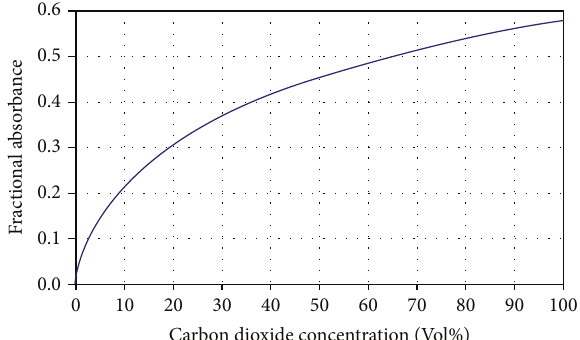
Figure 9: Absorbance fractional versus CO 2